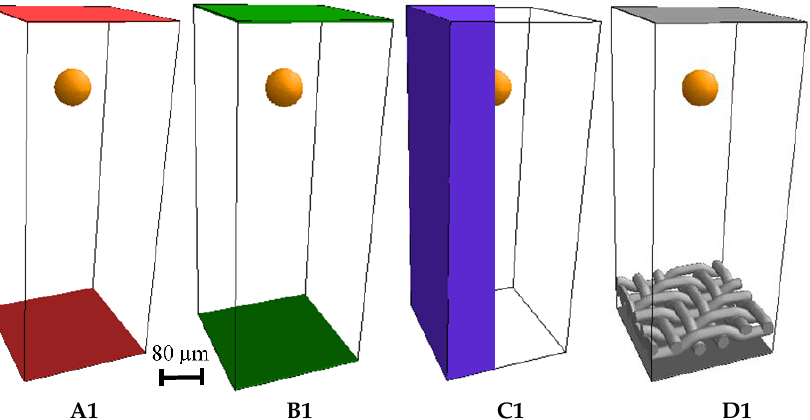
Figure 6. Different model arrangements to investigate particle settling behavior. The particle is 80 µm in diameter for each case. ( A1 ) Basic model with periodic boundaries, ( B1 ) basic model with coarser grid, ( C1 ) basic model with solid wall boundaries, ( D1 ) basic model with filter medium. In order to examine the influence of the boundary conditions and particle number additional models are created. Therefore, different sized containers were created with periodic boundaries (A2, A3,) and with solid wall boundaries (C2, C3) (Figure 7). Furthermore, models with two and three sedimenting particles are generated (A4, A5) (Figure 7). The simulation models are used to further verify the simulation method by comparing them to the empirical model of the particle settling velocity.